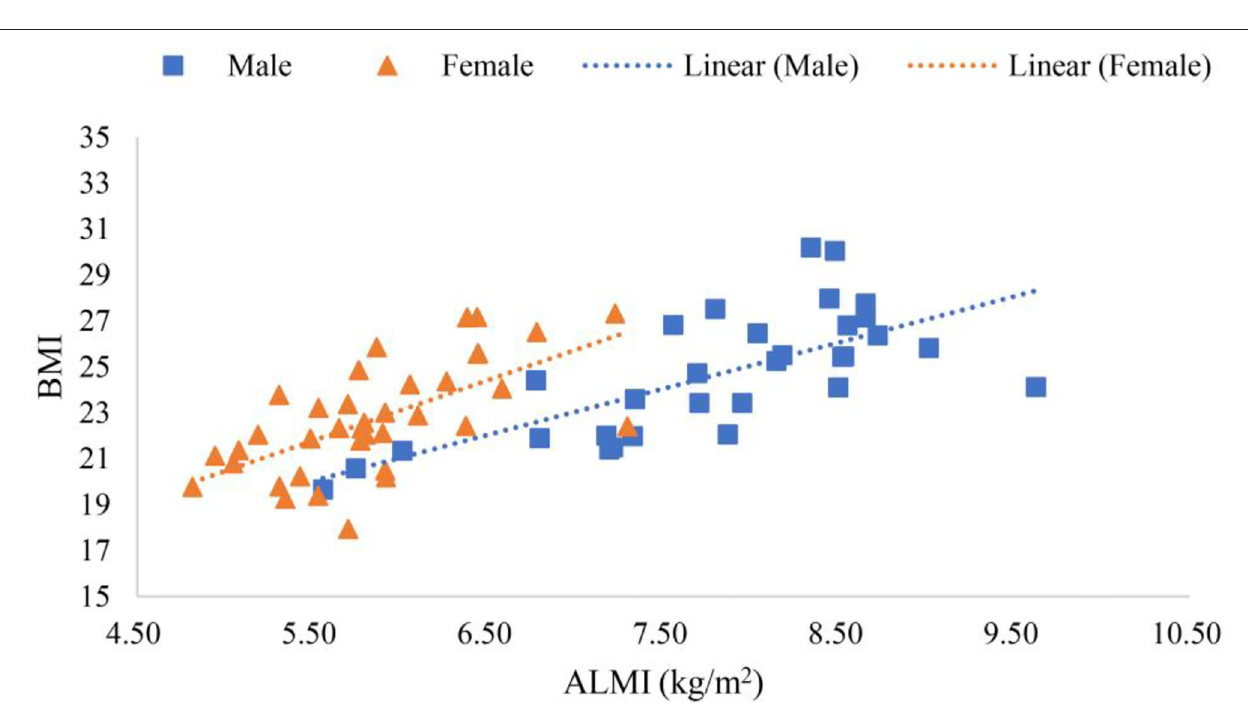
Table 3 demonstrates extremely significant differences in the length of right gait line and left single support line between the two groups ( p < 0.01). Significant differences were found